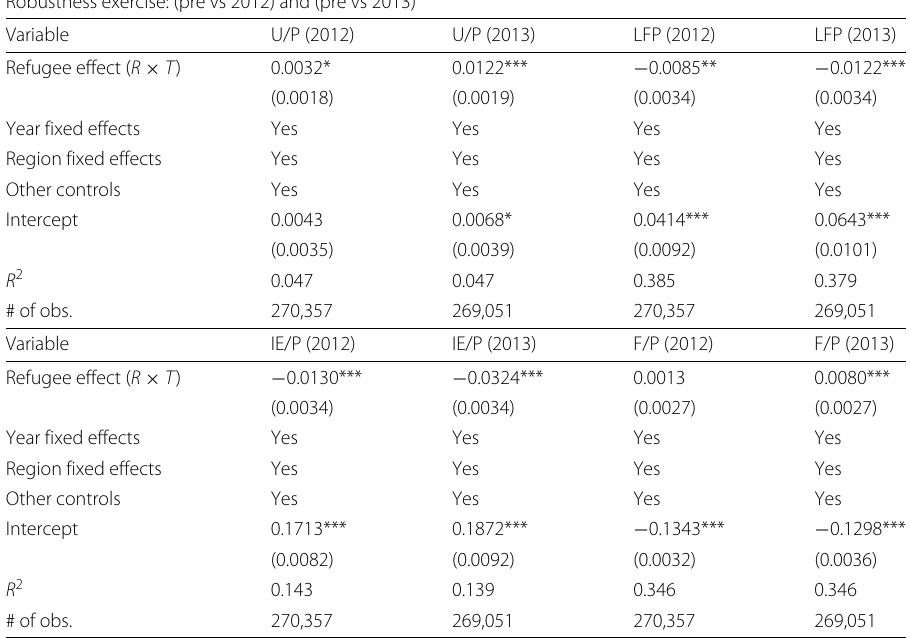
Robustness exercise: (pre vs 2012) and (pre vs